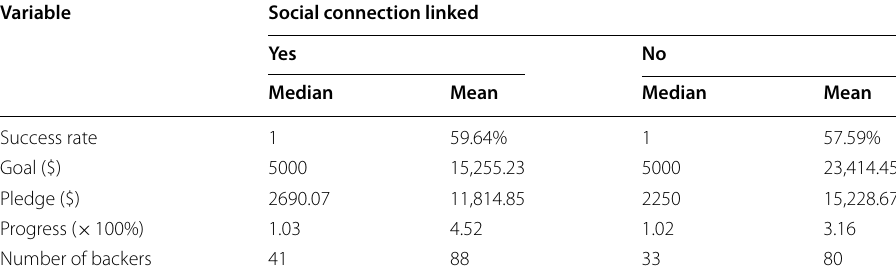
Table 3 Summary statistics for external social connections Variable